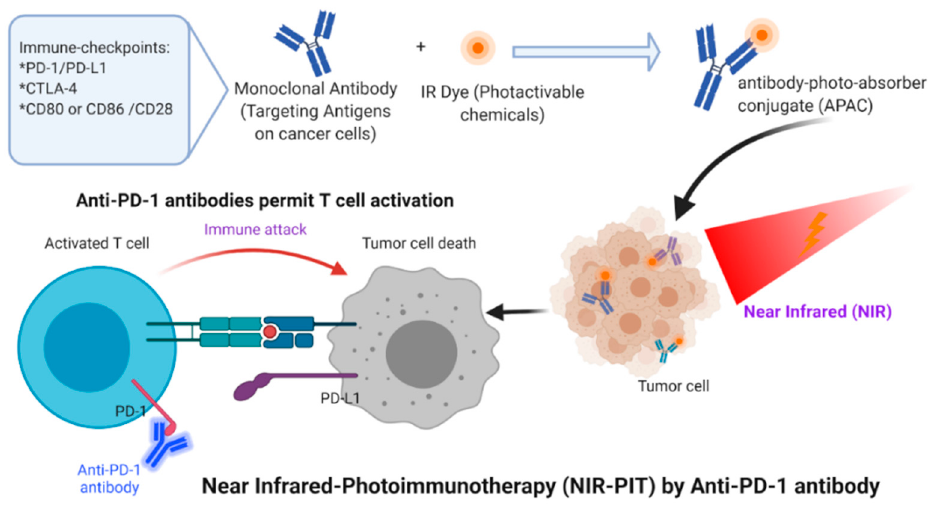
Figure 3. NIR-PIT for treating cancer cells. This therapy can involve injecting a monoclonal antibody conjugated with a photoabsorber followed by exposure to near-infrared light at the tumor site.